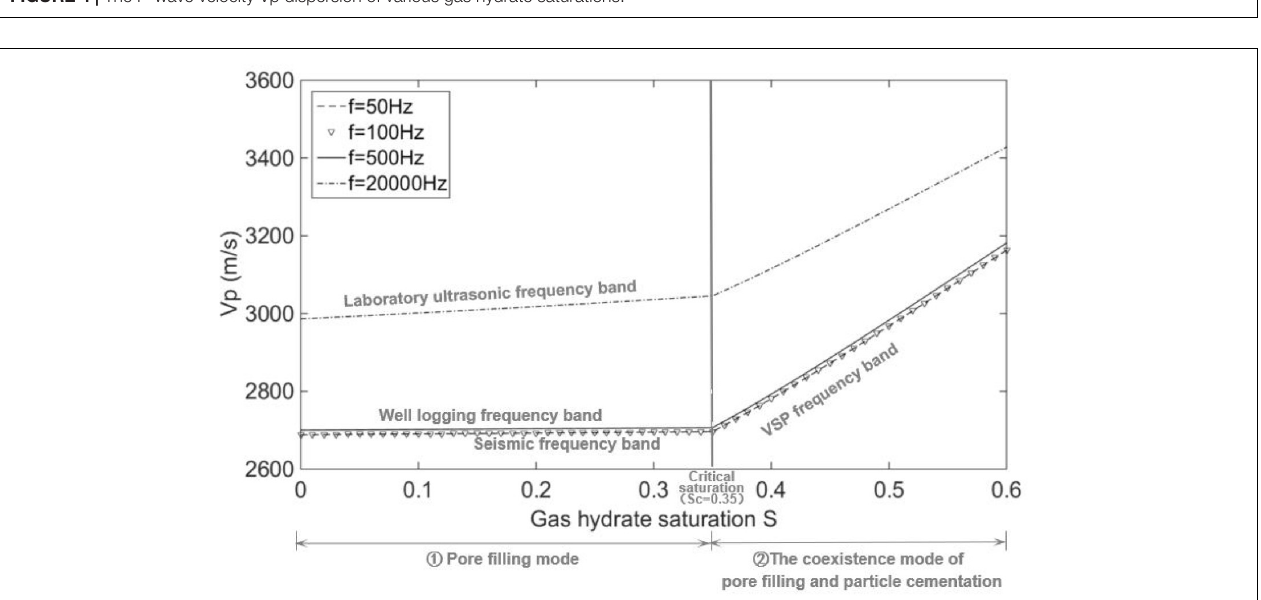
FIGURE 4 | The P-wave velocity Vp dispersion of various gas hydrate saturations.